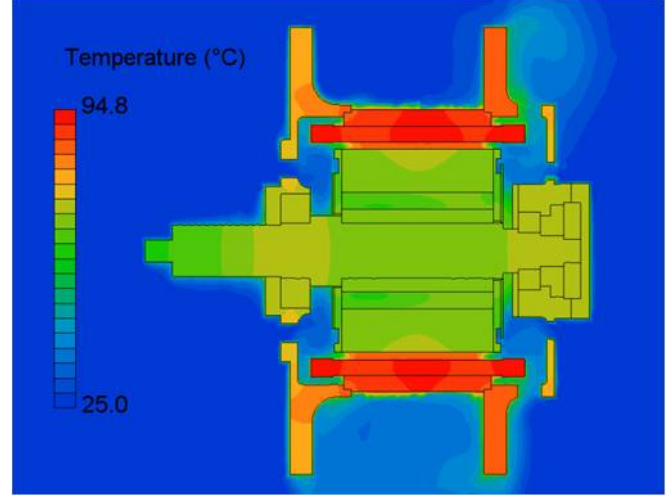
Figure 7. Temperature contours of the ISG operating at an ambient temperature of 25  C and a motor speed of 4500